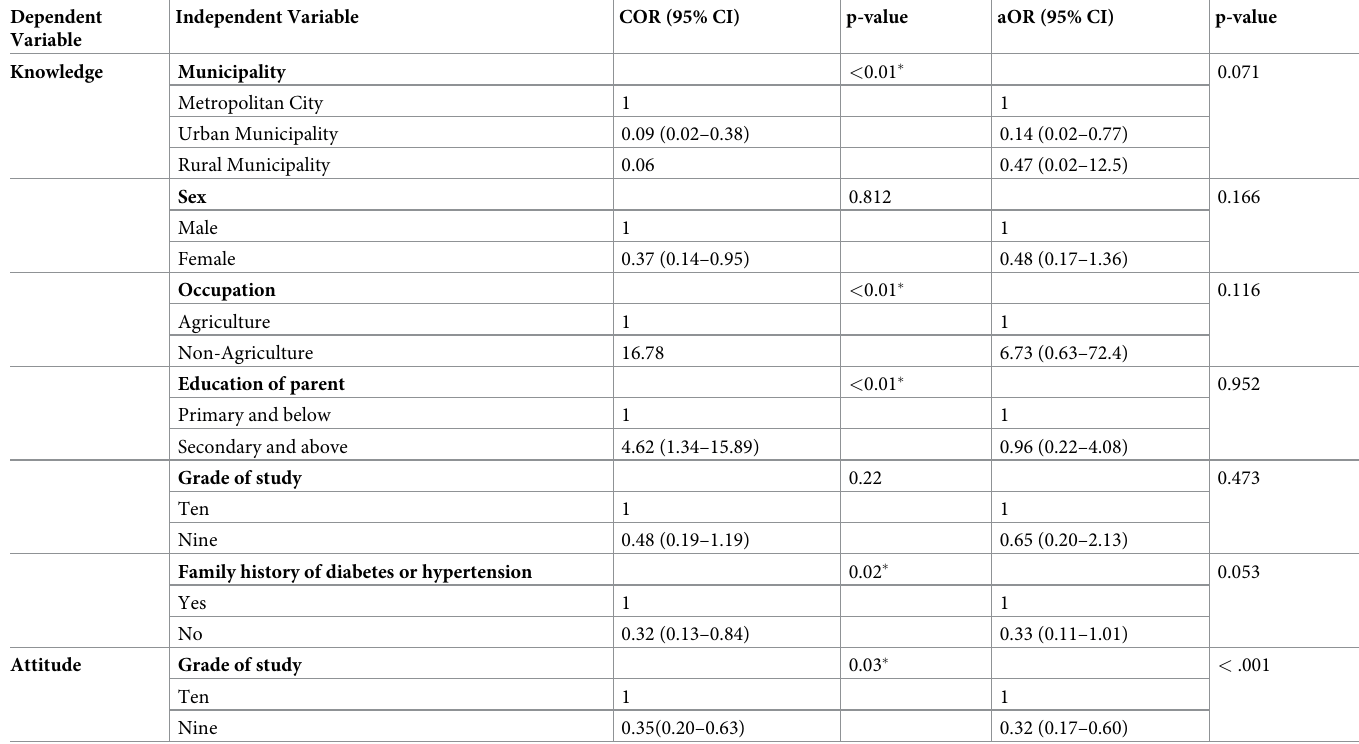
Table 7. Multivariate logistic regression analysis showing predictors of knowledge and attitude levels (good vs. not good). Dependent